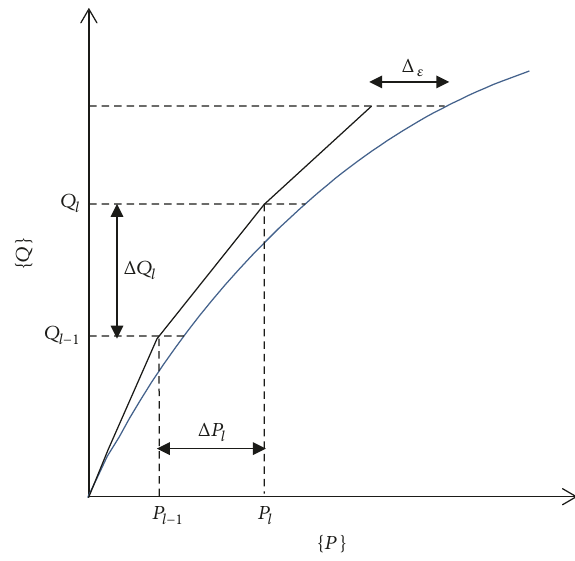
Figure 5: Relationship between the flow rate and pore pressure in the incremental method.